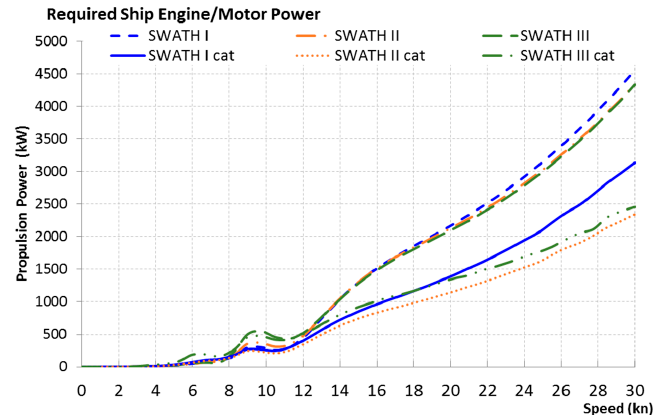
Figure 9. Approximate plot of the required propulsion power versus longitudinal speed for SWATH I, SWATH II and SWATH III ships depending on float submerged/surfaced mode.